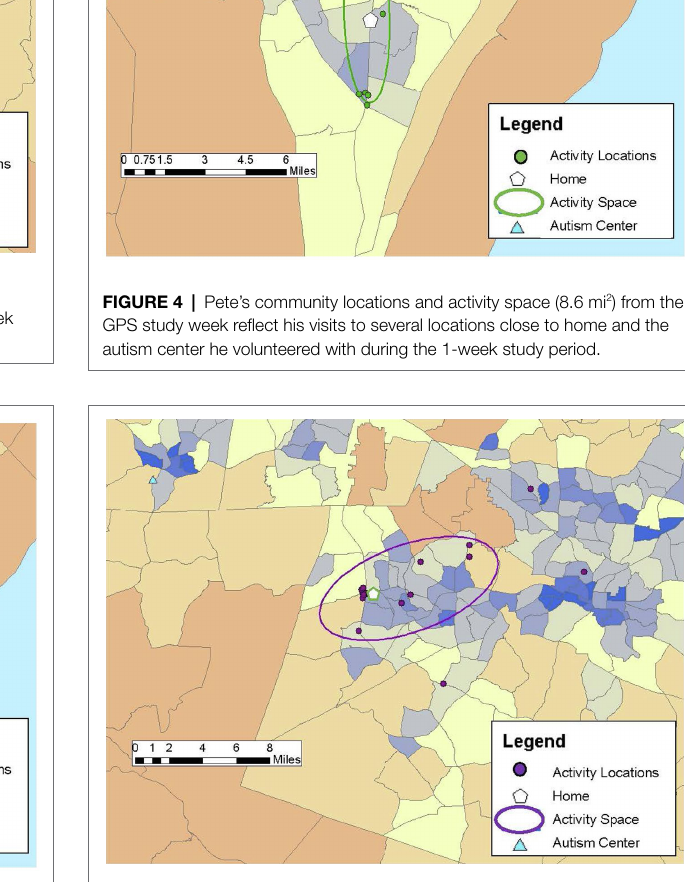
FIGURE 5 | Patti’s activity space (44.72 mi 2 ) based on locations visited in the community during the 1-week study period, reflecting a combination of activities clustered around her home and those requiring greater geographic mobility.